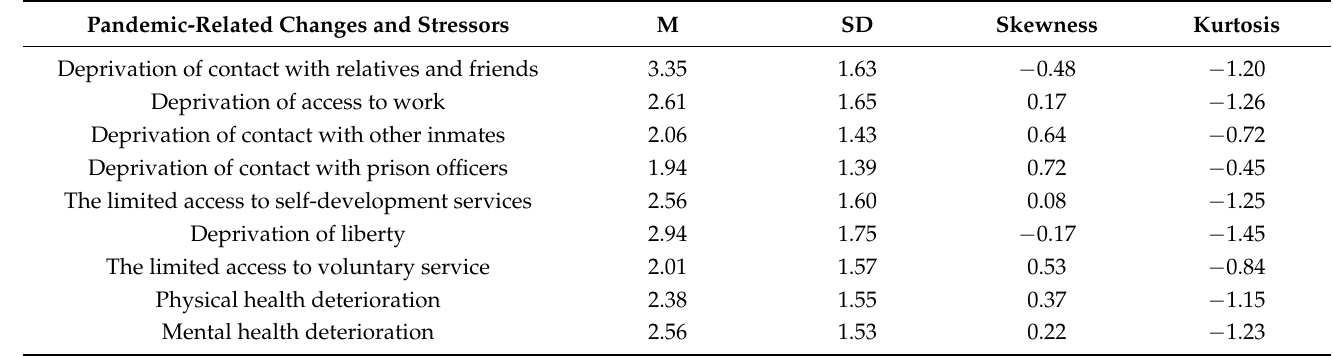
Table 2. Descriptive statistics for COVID-19 pandemic-related changes and stressors in inmates’ opinion (N = 250).